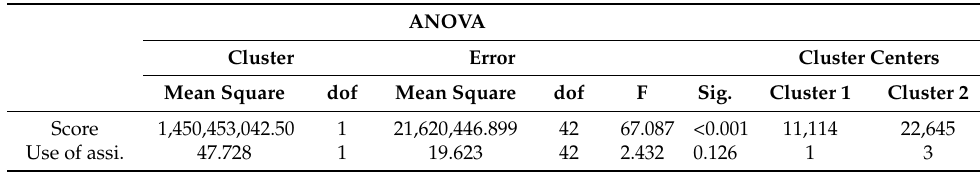
Table 4. ANOVA result of the clustering according to score and the number of users of the assistance system variables, and the final cluster centers.